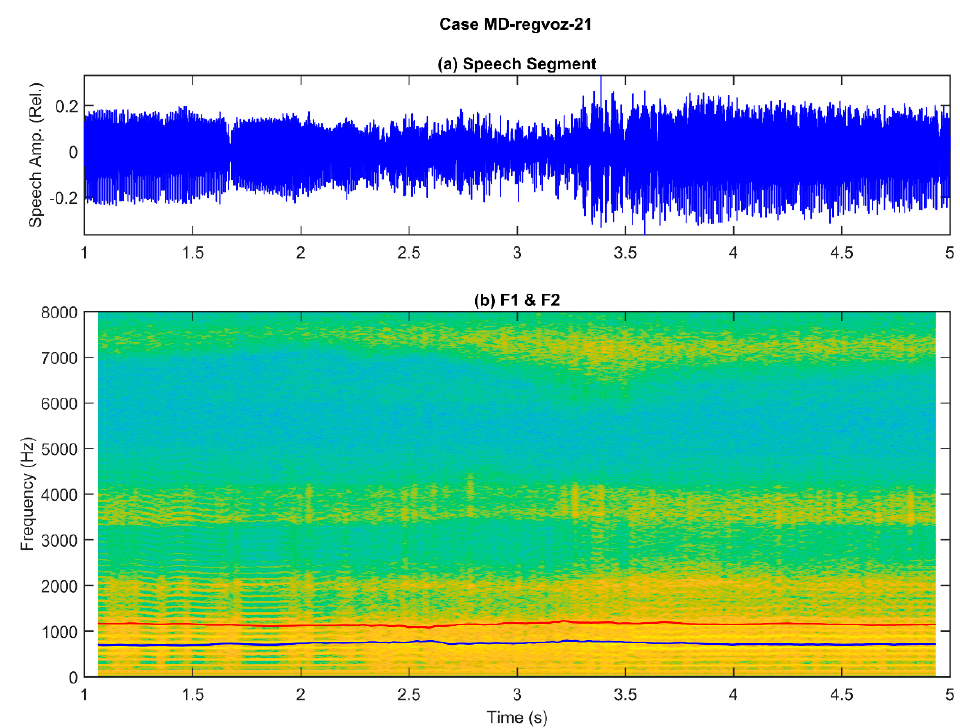
Figure 2. Example of a sustained utterance of the vowel [a:] from a patient suffering a larynx car- cinoma (male, 61 years old): ( a ) original speech signal, showing strong amplitude and frequency changes through the utterance (rough and unstable phonation); ( b ) spectrogram on the background and two formants in blue (first formant) and red (second formant). The harmonic spectrum (back- ground) shows unstable harmonics, especially from 2.3 s, seen as horizontal yellow parallel bands, showing tremor, and blurring between 2.4 and 3.5 s, which extend from 125 Hz to barely 1200 Hz, indicating a poor voice quality produced by an abnormal larynx function. The first two formants (blue and red lines) show fluctuations, especially apparent from 2.3 s to 3.5 s, indicating possible difficulties in keeping a stable oral opening during phonation, as both lines do not maintain a constant separation.